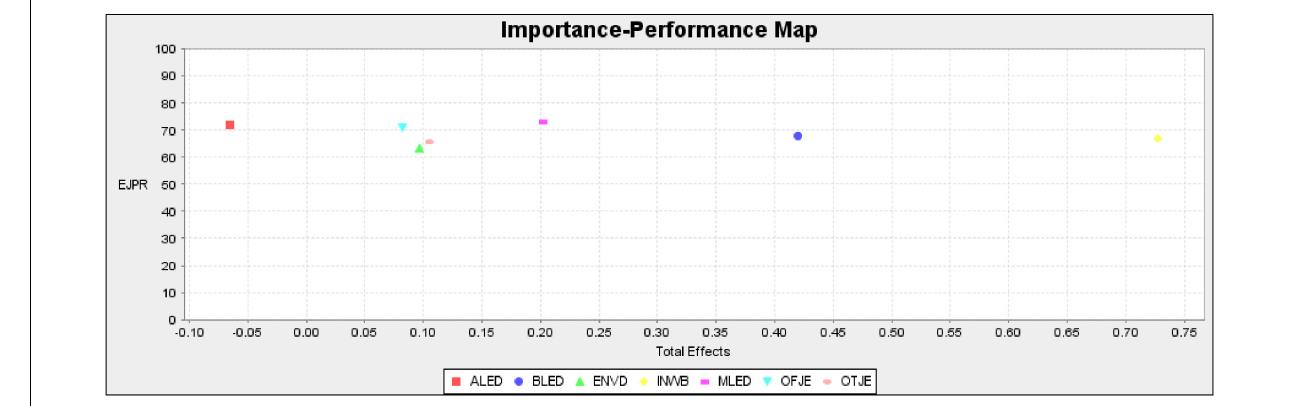
FIGURE 2 | Importance performance matrix map.